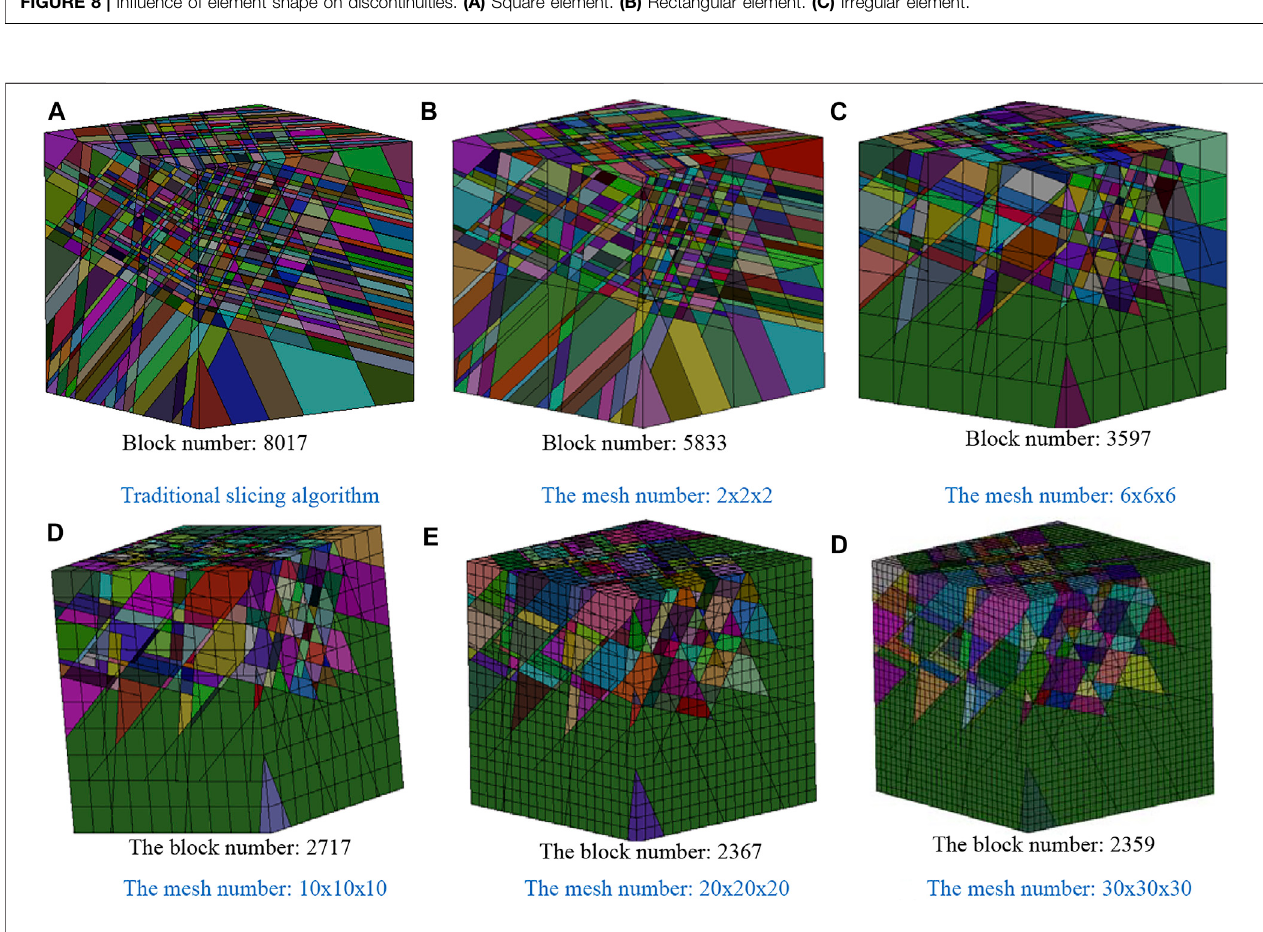
FIGURE 9 | The in fl uence of mesh number on the block system. (A) Traditional slicing algorithm. (B) The mesh number: 2 × 2 × 2. (C) The mesh number: 6 × 6 × 6. (D) The mesh number: 10 × 10 × 10. (E) The mesh number: 20 × 20 × 20. (F) The mesh number: 30 × 30 × 30.